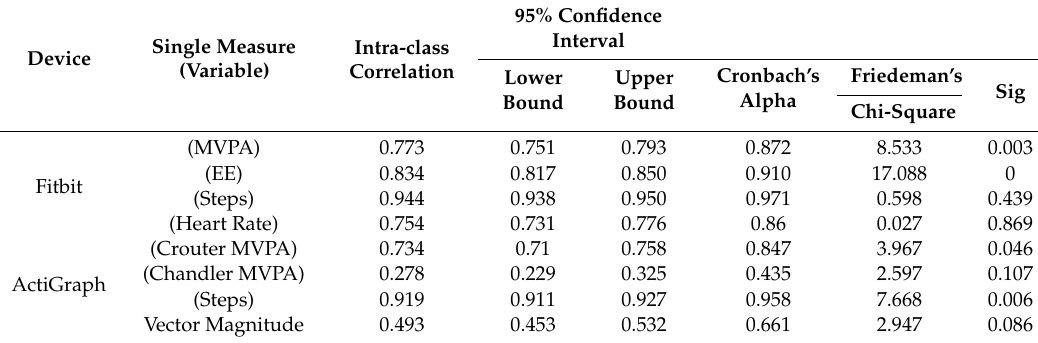
Table 4. ICC for dominant vs. non-dominant worn trackers using single-rating, absolute-agreement, and 2-way mixed e ff ects models.